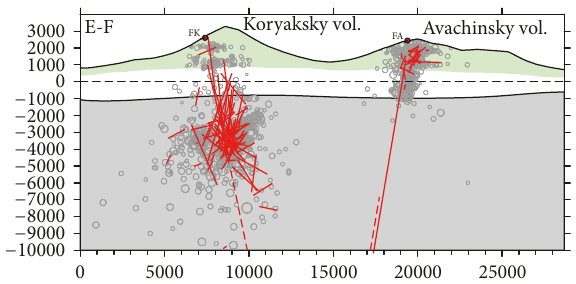
Figure 4: Geological cross-sectional EF (see Figure 1). Legend is the same as in Figure 2, and axes are labeled in